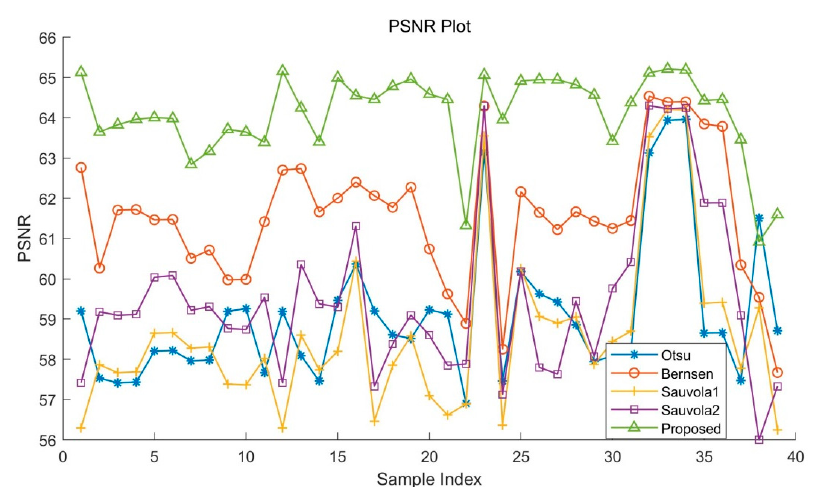
Figure 17. PSNR of the dataset with different algorithms.